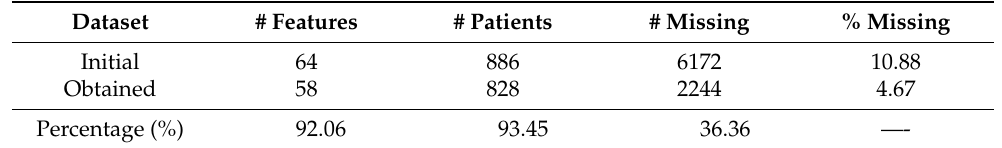
Table 2. Summary of the obtained database after eliminating features and instances from the original dataset because of a high percentage of missing values. Symbol # stands for ‘number’.